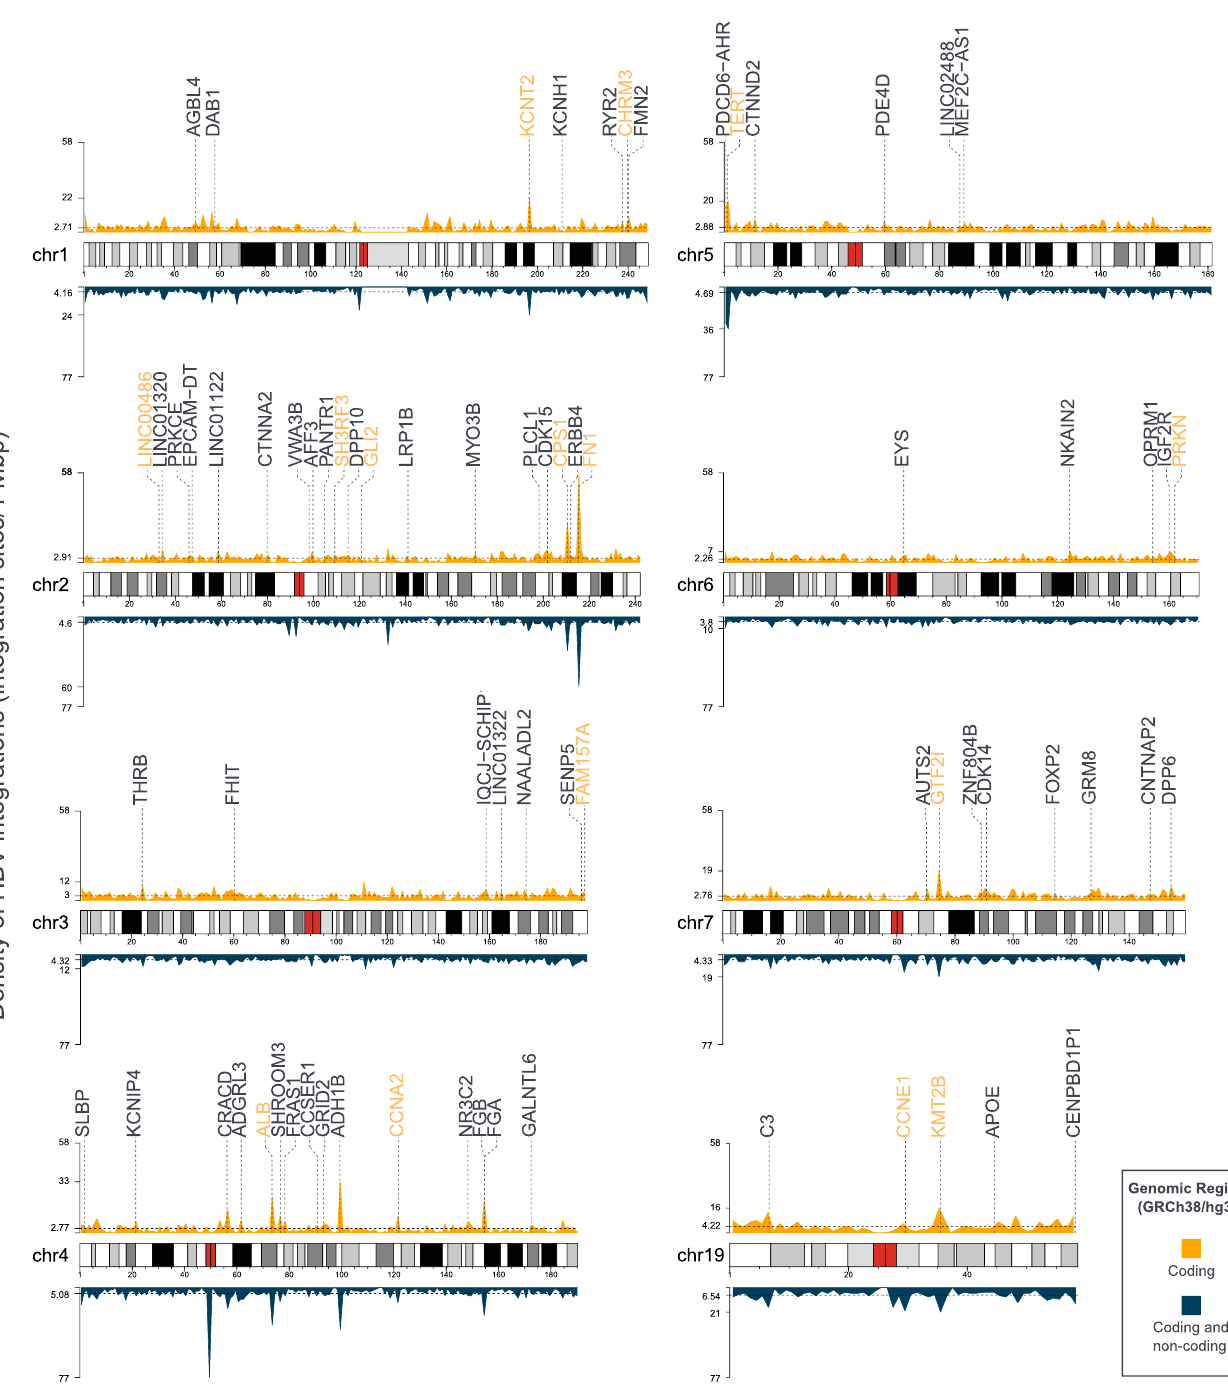
Figure 4. HBV DNA integration density plots for the chromosomes 1–7 and 19 in which the recurrently affected genes are localized. The yellow density plots represent the density of integrations per 1 Mbp (1,000,000 bp) through the chromosome that are referring to coding genomic regions, while the blue density plots represent the density of integrations per 1 Mbp that are referring to all genomic regions (coding and non-coding). The mean values are depicted via the horizontal dashed lines, and the locations of the main target genes are also present. The plots were generated with the karyoploteR R package